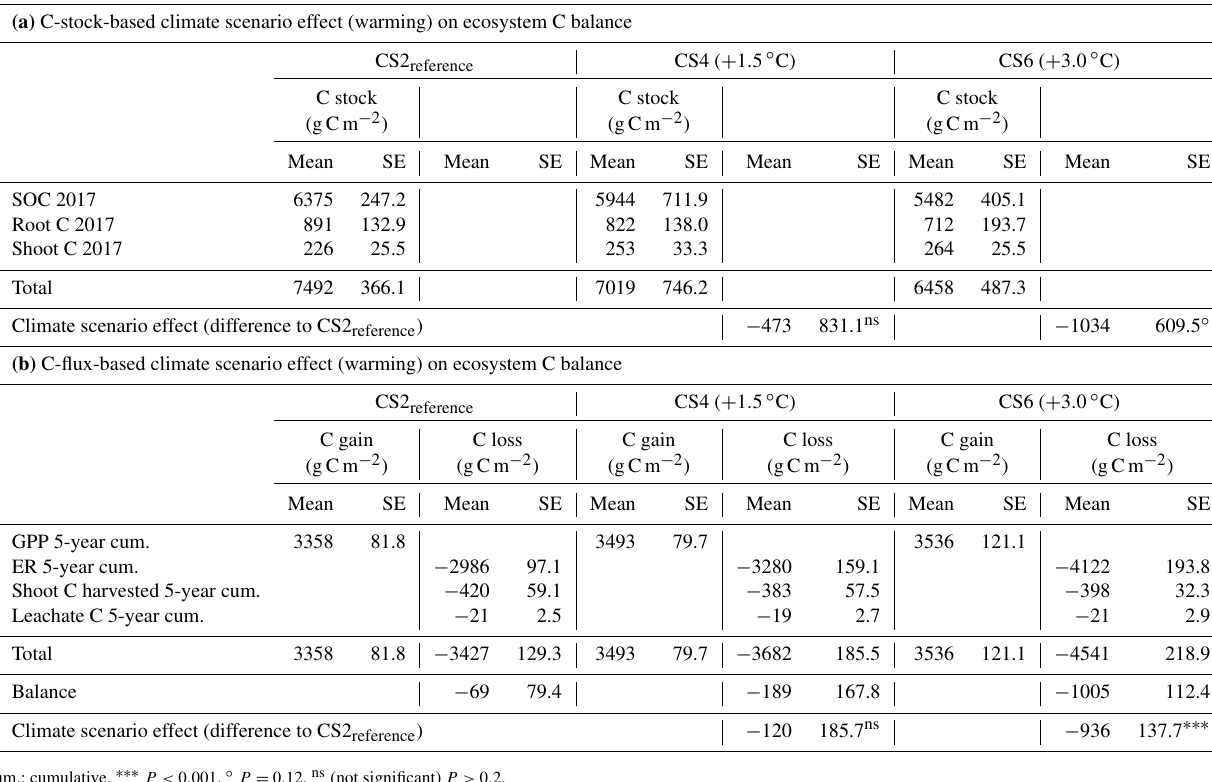
Table 3. Net ecosystem C balance for CS2 reference , CS4 and CS6, alternatively based on C stocks (a) and C fluxes (b) . Data for all stocks and fluxes are means ± 1 SE from the same six control monoliths per CS that received neither irrigation nor additional